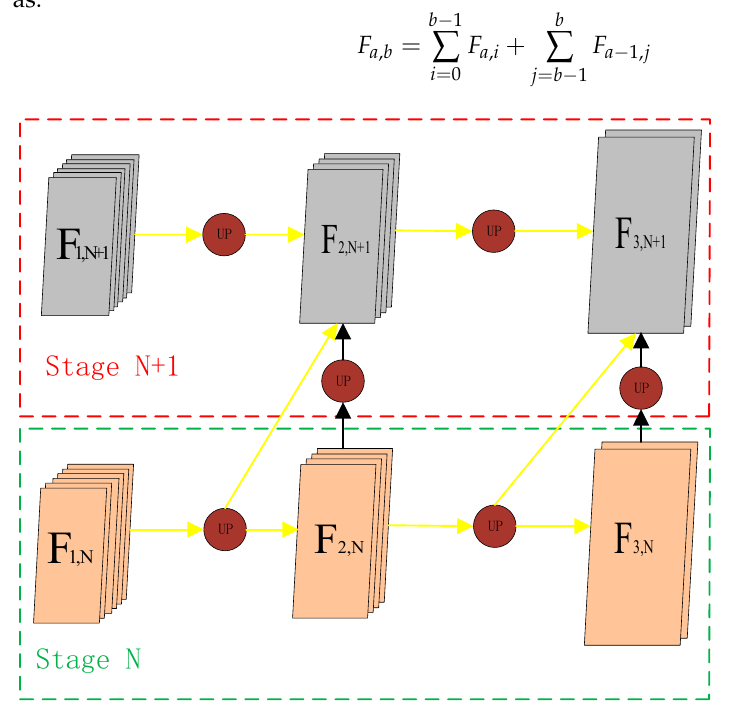
Figure 3. The overall structure of cross-resolution fusion module. The yellow line in the figure indicates the cross-resolution connection, where the high-resolution features fuse the low-resolution feature information of different stages.